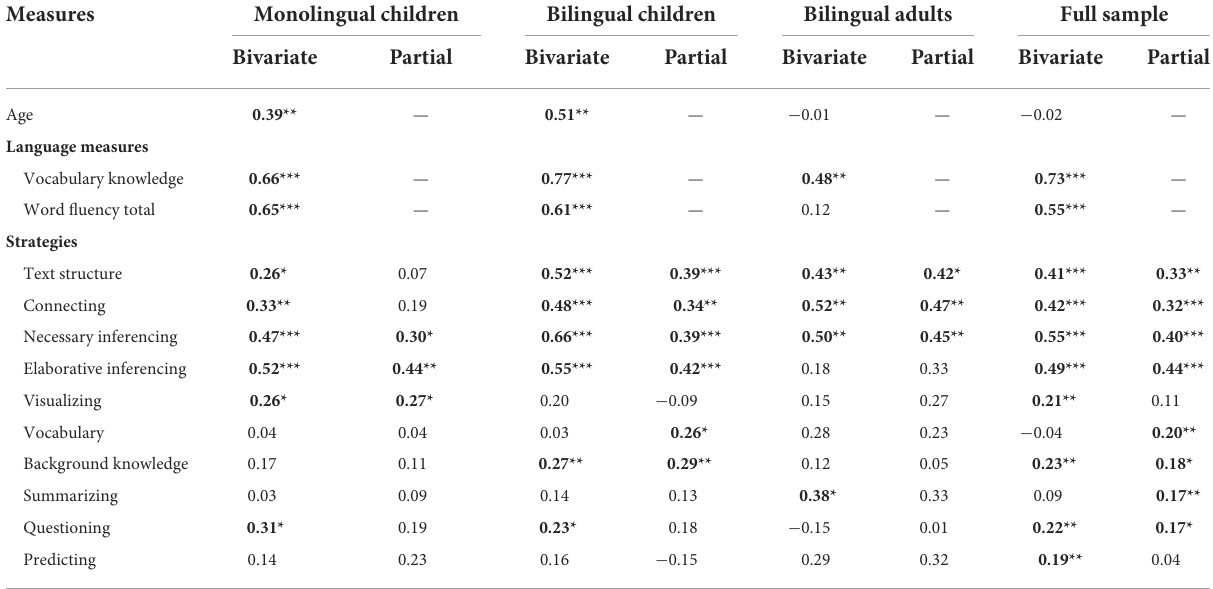
TABLE 3 Correlations of language measures and strategy use with RC scores for all three language groups. Measures